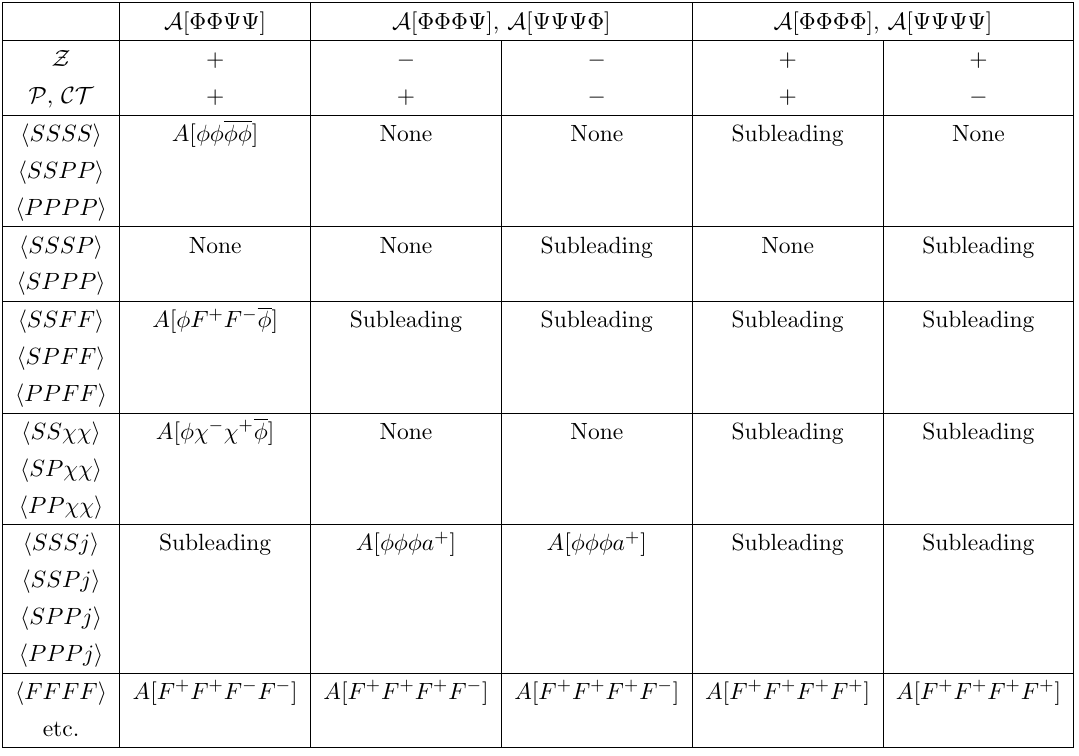
Table 5 . Examples of CFT four-point correlators that contribute to the (cid:12)ve superconformal in- variants. Each superconformal invariant can be labeled by its transformation properties under the discrete symmetries P and Z . For every CFT correlator in the (cid:12)rst column, we list how it con- tributes to the superconformal invariants in Mellin space: either at leading order, in which case we list the scattering amplitude it should match at this order; either at subleading order, in which